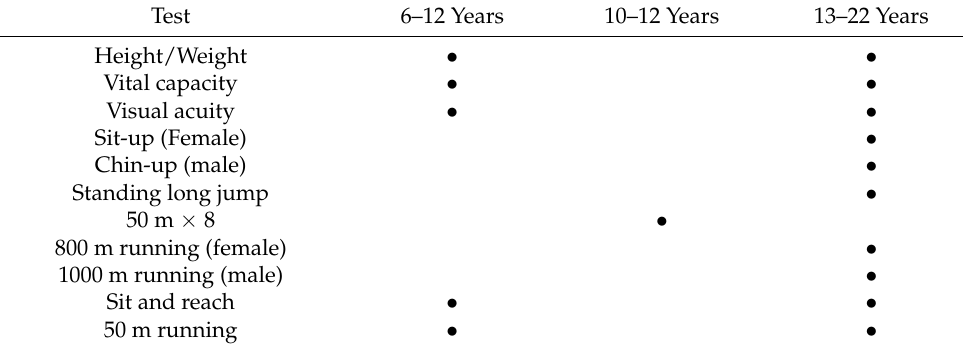
Table 2. Test projects and test